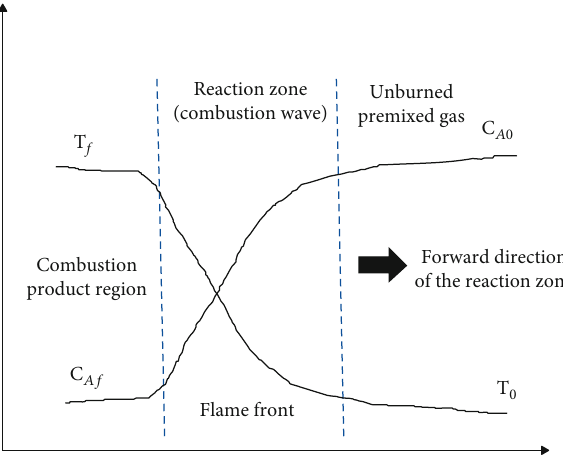
Figure 1: Combustion wave propagation